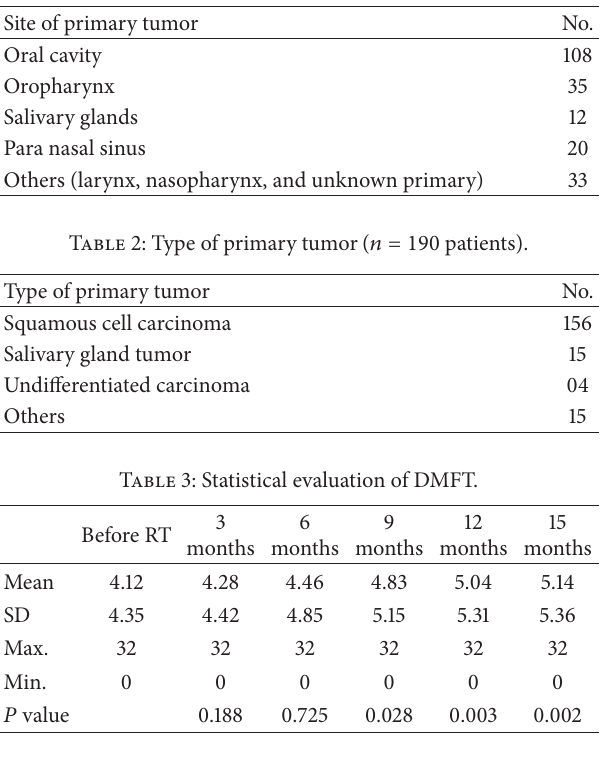
Table 1: Site of primary tumor (𝑛 = 190 patients).